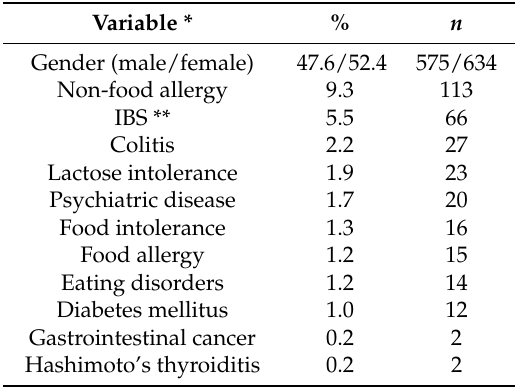
Table 1. Demographics and clinical characteristics of the studied population. Variable * % n Gender